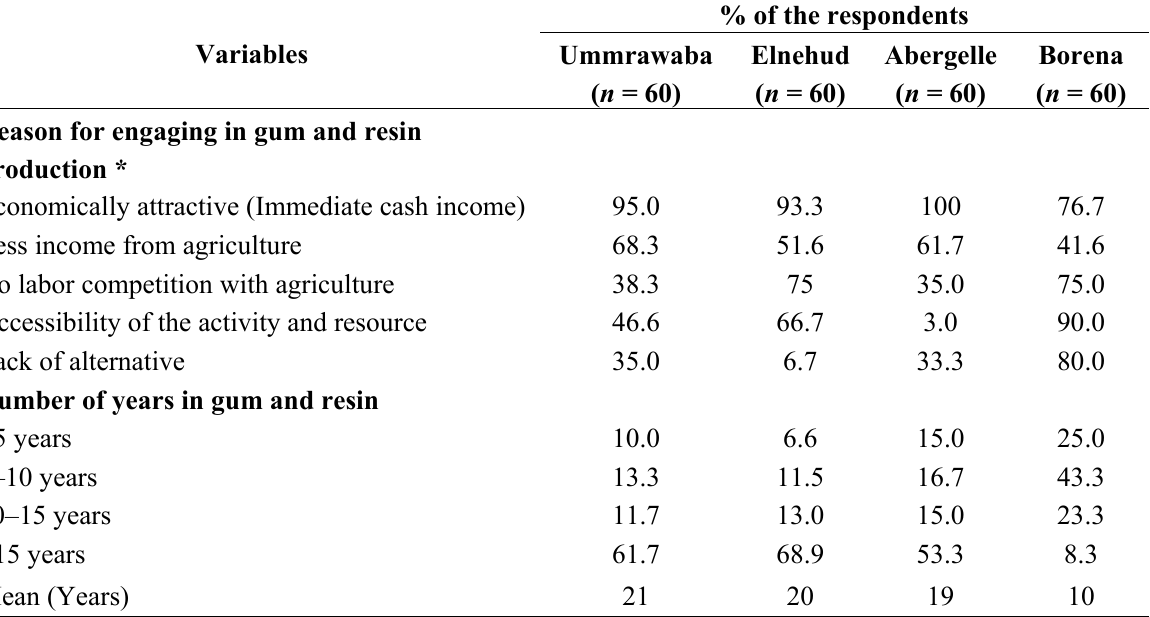
Table 3. Motivations for entering in gum and resin production and number of years participating in the